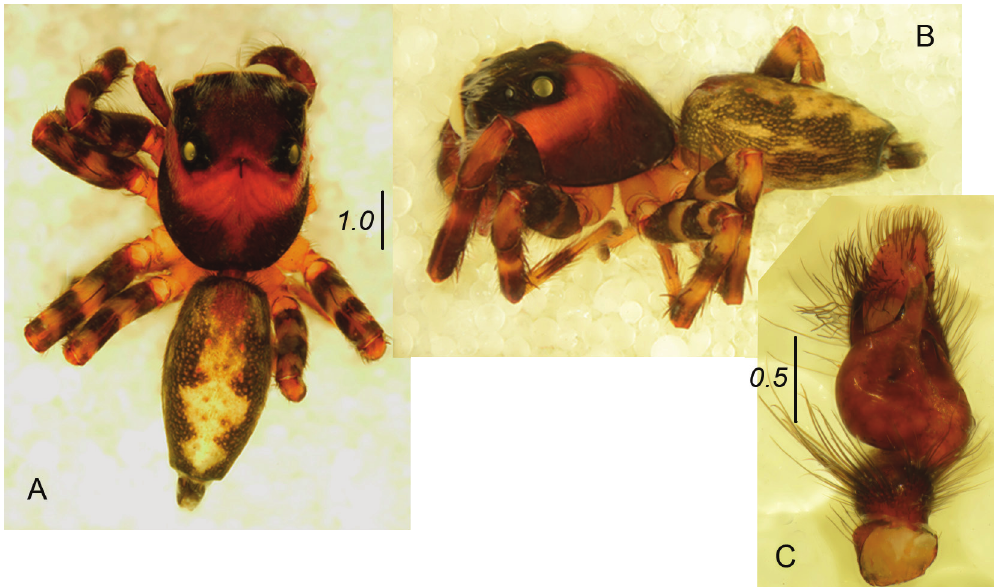
Fig. 1. Thiratoscirtus oberleuthneri sp. nov., holotype, male. A . General appearance, dorsal view. B . General appearance, lateral view. C . Palp, ventral view. scale bars: a–B = 1 mm, C =